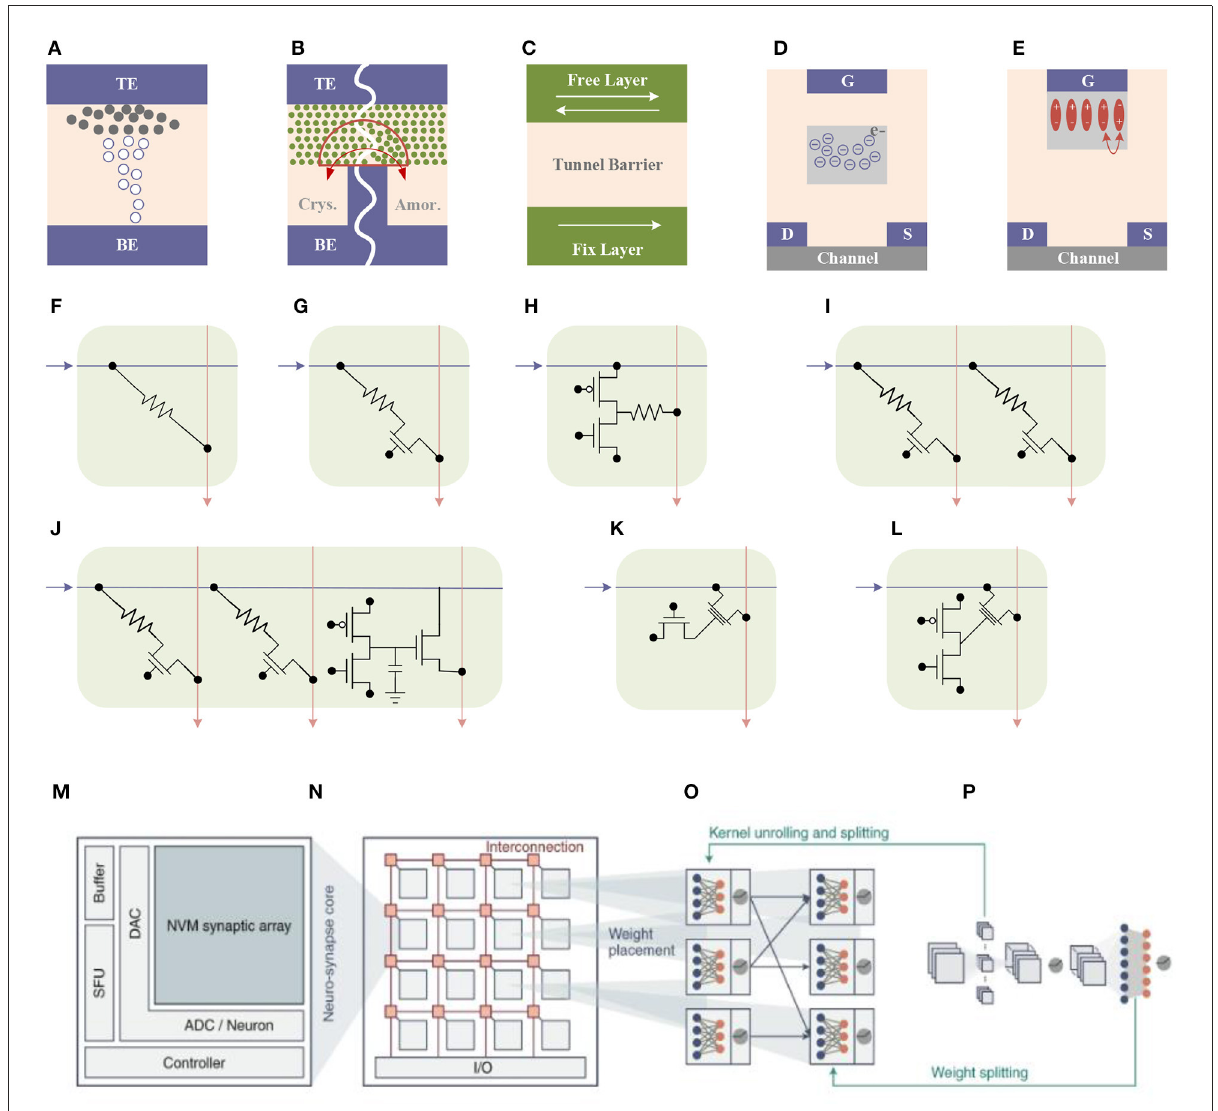
FIGURE8 Two-terminal devices: (A) RRAM, (B) PCM, and (C) MRAM. Three-terminal devices: (D) flash memory and (E) FeFET. Post-silicon nano-electronic device-based cell structure: (F) 1R synapse, (G) 1T1R synapse, (H) 2T1R synapse, (I) 2T2R synapse, (J) 2T2R + 3T1C synapse, (K) 1T + 1TriR synapse and (L) 2T + 1TriR synapse. (M) neuro-synapse core, (N) neuro-synapse core in brain-inspired chips (O, P) neural network working process (Zhang W. Q. et al.,